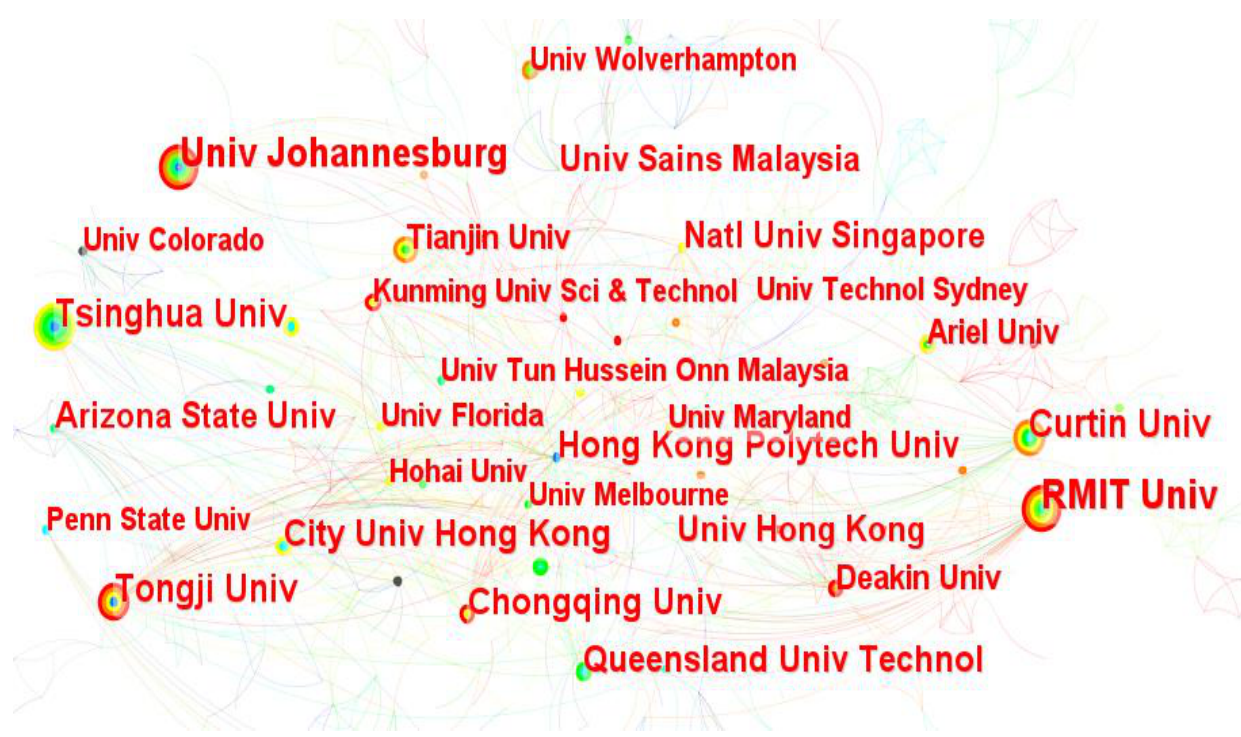
Figure 5. Institution collaboration network .